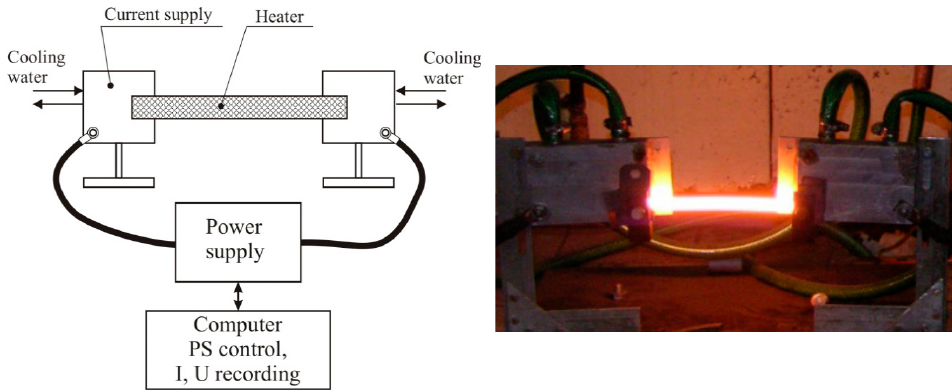
Figure 15. Scheme of the stand and a photograph of the testing process for the mRSiC heater with a protective SiC coating.